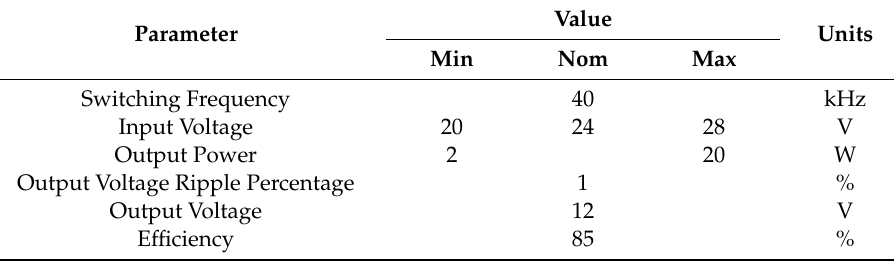
Table 2. Design parameters of the three-phase Voltage Source Inverter (VSI).